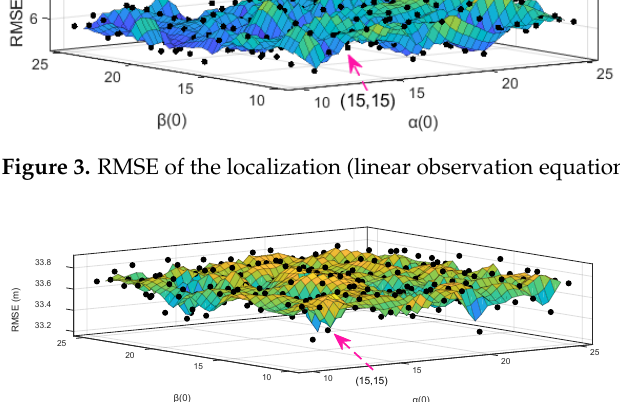
Figure 4. RMSE of the localization (nonlinear observation equation).